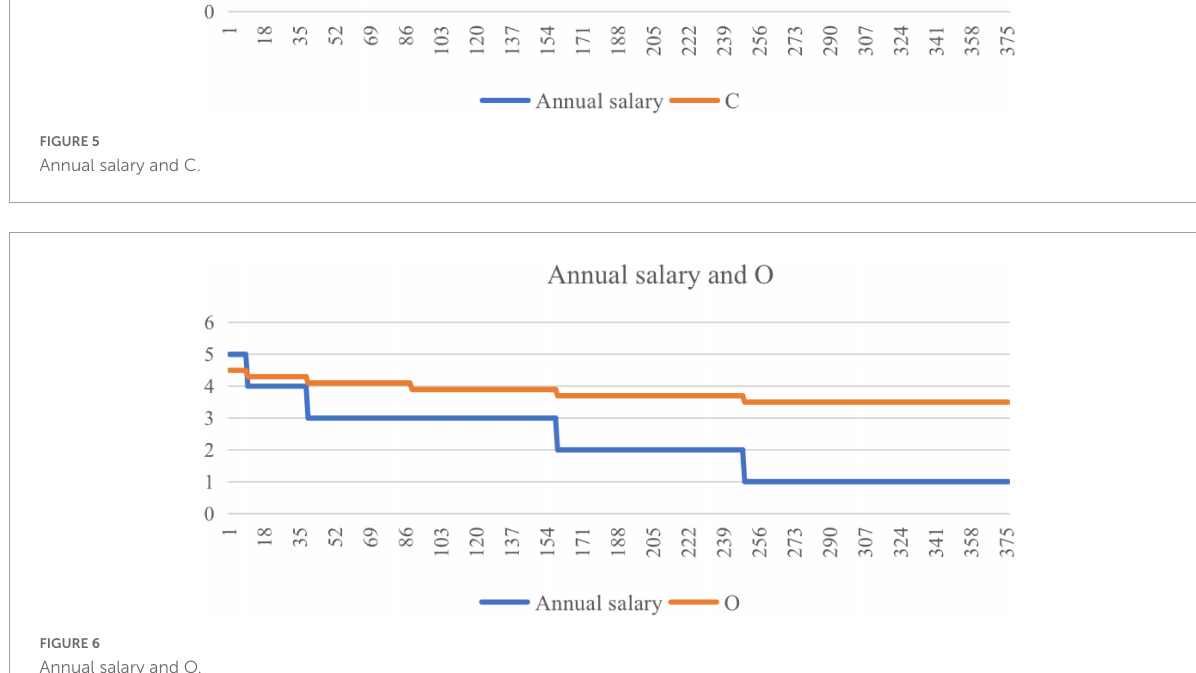
FIGURE5 Annual salary and C.